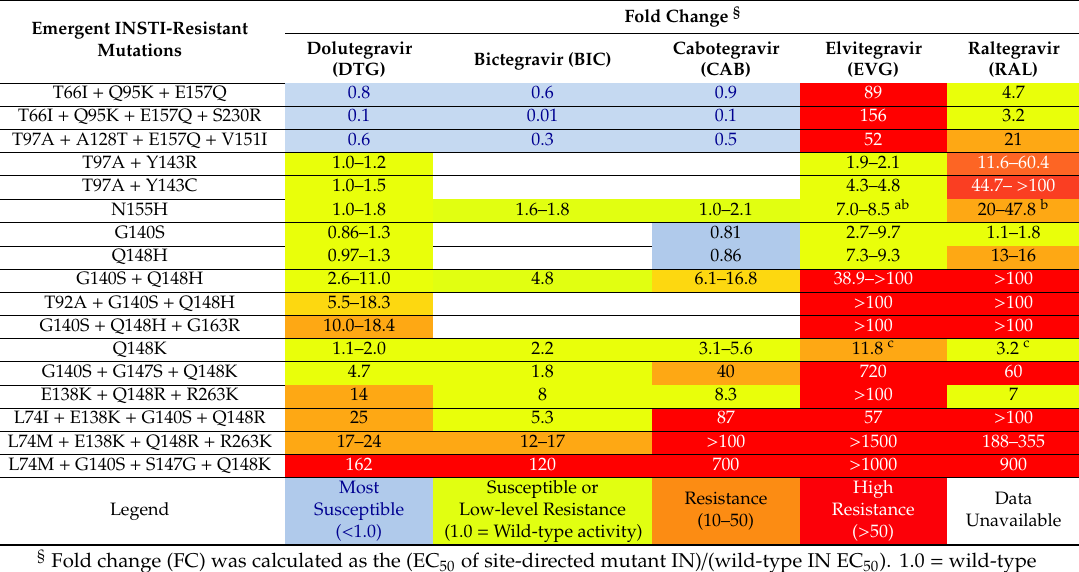
Table 3. INSTI resistance from emergent HIV-1 integrase